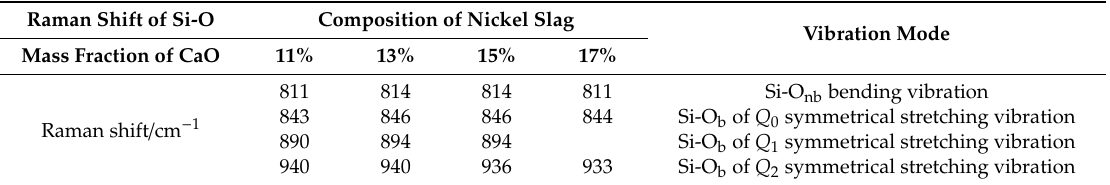
Table 3. Location of Raman characteristic peaks of nickel slag with different CaO content quenched at 1150 °C.